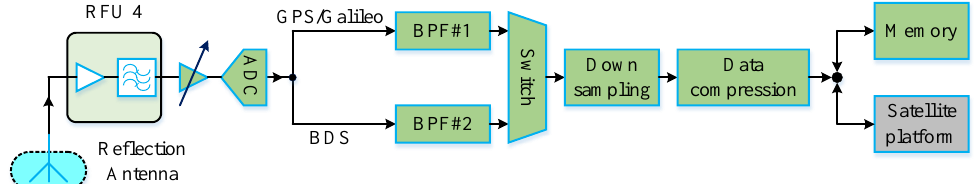
Figure 5. Signal processing structure for collecting raw IF data in the GNSS-R module of the